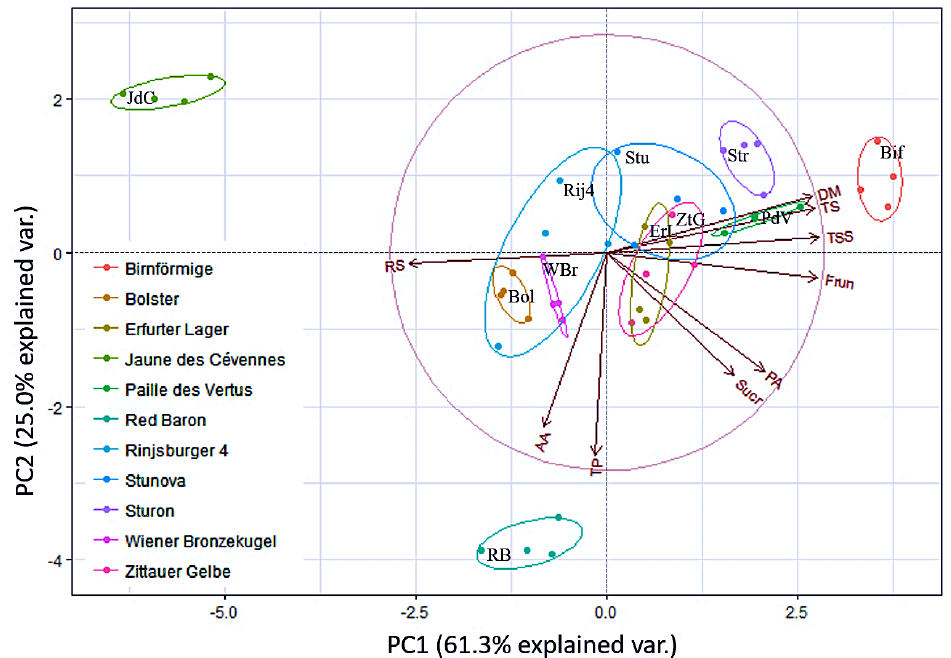
Fig. 5: Principal component analysis (PCA), describing the relationship among varieties depending on their quality traits. Quality traits: DM = Dry Matter, TS = Total Sugar, TSS = Total soluble solids, Frun = Fructan, PA = enzymatically produced pyruvic acid, Sucr = Sucrose, TP = Total Phenolics, AA = Antioxidant Activity, RS = Reducing Sugar. Onion varietiesare grouped by colors as shown in the figure. Points represent the biological replications of each variety n = 4. Jaune des cévennes (JdC), Sturon (Str), Stunova (Stu), Bolstar (Bol), Wiener Bronzekugel (WBr), Rijnsburger 4 (Rij4), Birnförmige (Bif), Erfurter Lager (ErL), Zitauer Gelbe (ZtG), Paille des Vertus (PdV), Red Baron